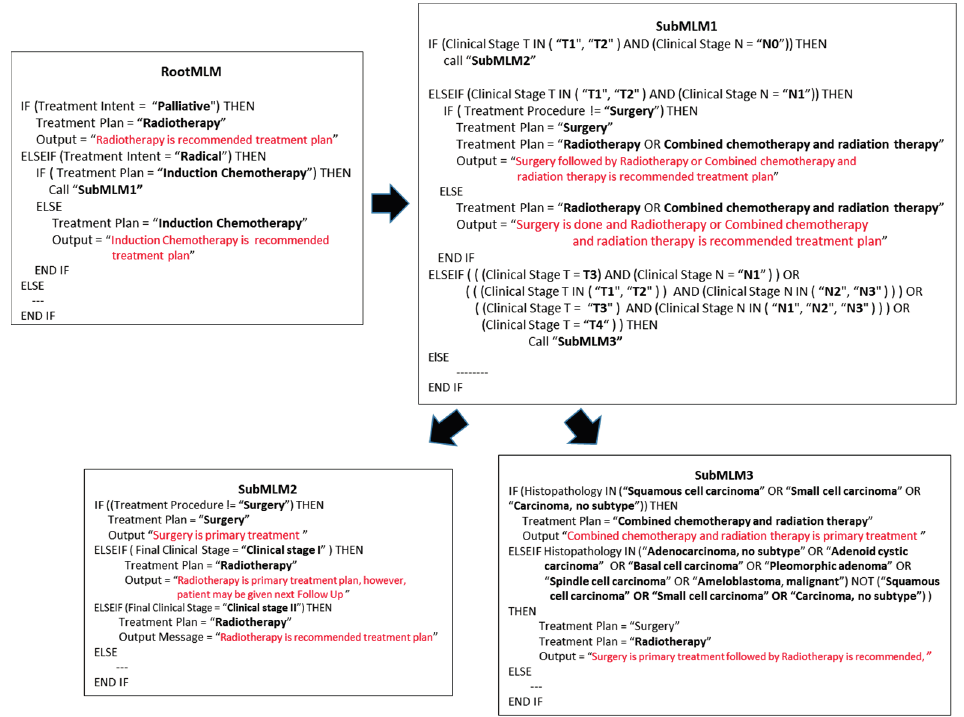
Figure 5. Selected MLMs for the oral cavity site of head and neck cancer embodied with Logic